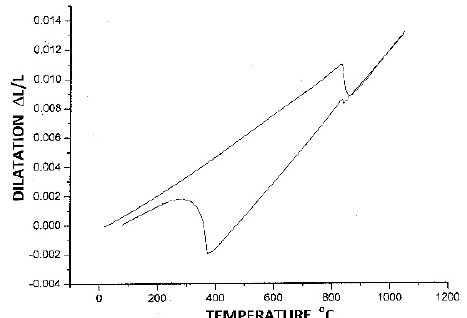
Figure 2. Dilatometer curves for a heating and cooling cycle for P91 steel. The length contraction at higher temperature corresponds to the formation of austenite and the expansion at lower temperatures signals the formation of martensite [35].